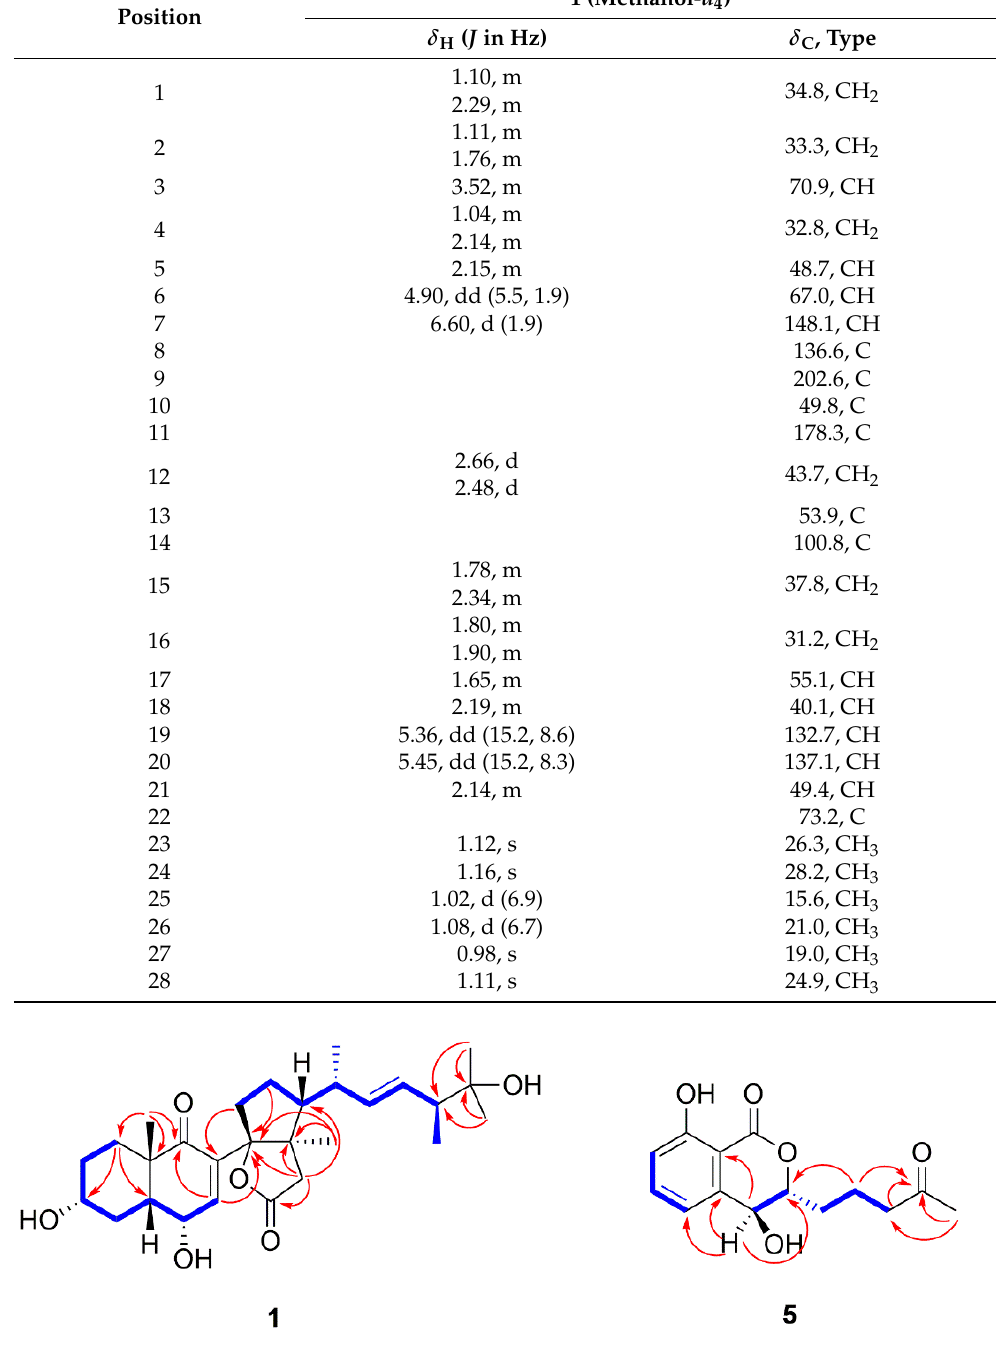
Table 1. 1 H and 13 C NMR data for compound 1 (methanol- d 4 ).